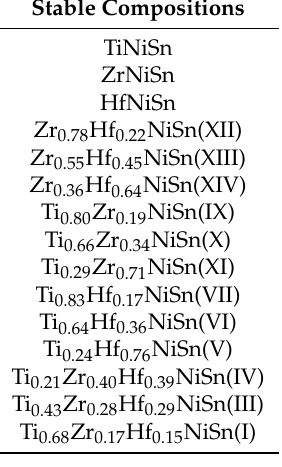
Table 10. Compositions of the stable Heusler phases with an error range of